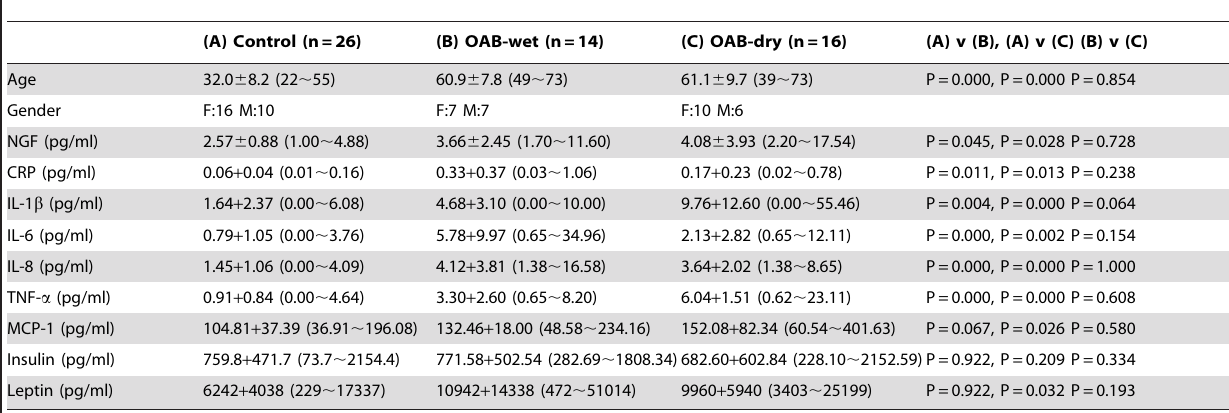
Table 1. The CRP, NGF, and adipokines expressions among the controls, OAB-dry, and OAB-wet.